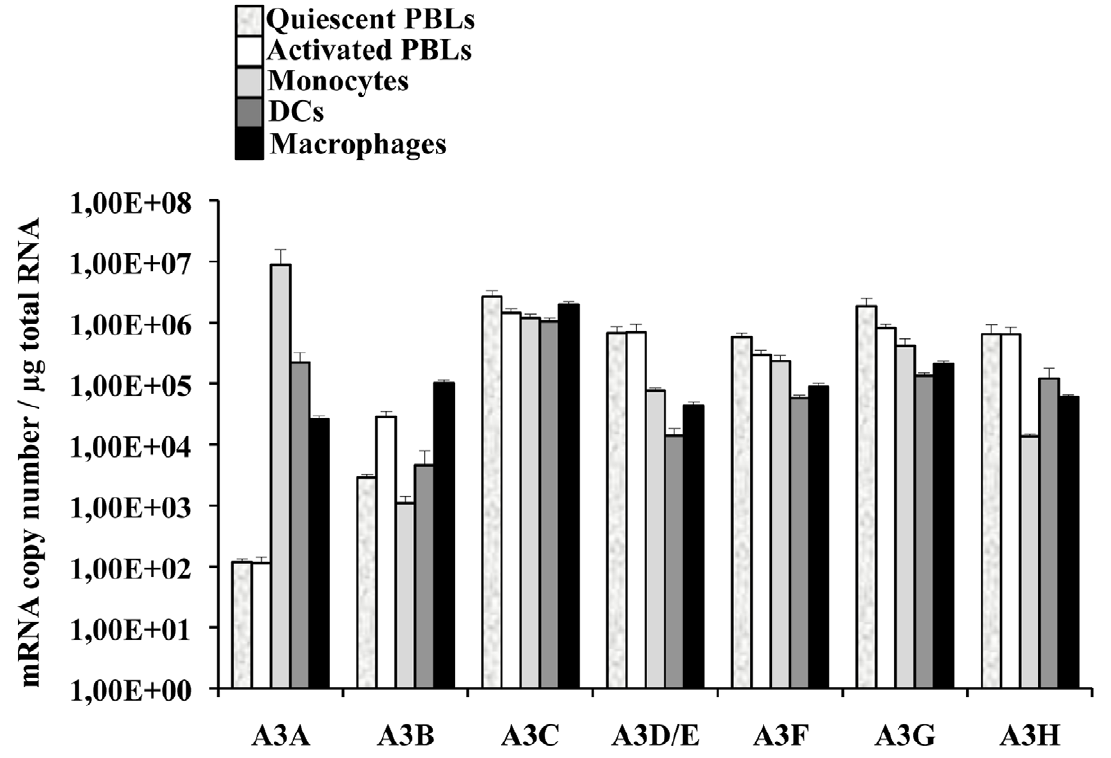
Figure 1. A3A is preferentially expressed in myeloid cells. Primary blood monocytes, monocyte-derived macrophages and DCs were compared to PBLs either quiescent or stimulated for 24 hrs with PHA/IL2 to determine the amount of mRNA of the different members of the APOBEC3 family using primers specific for each member, as already described in [44]. The graph presents results obtained from cells derived from 4 different donors.